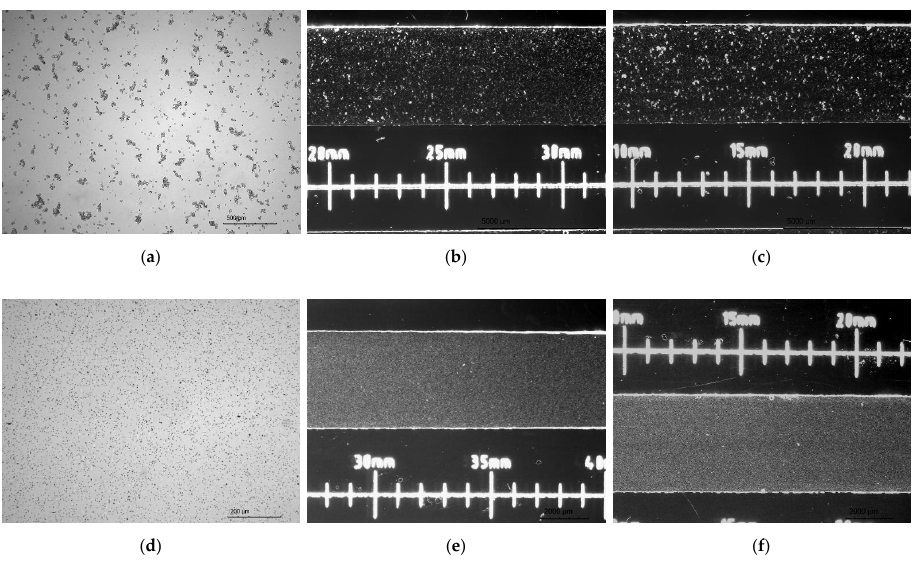
Figure 3. ( a – c ) Distributions of cells after seeding in a culture chamber; ( d – f ) Distributions of melamine microparticles after seeding in a culture chamber.